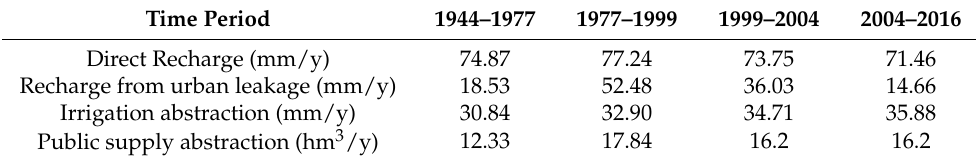
Table 2. Groundwater budget of the Maltese islands for different time periods